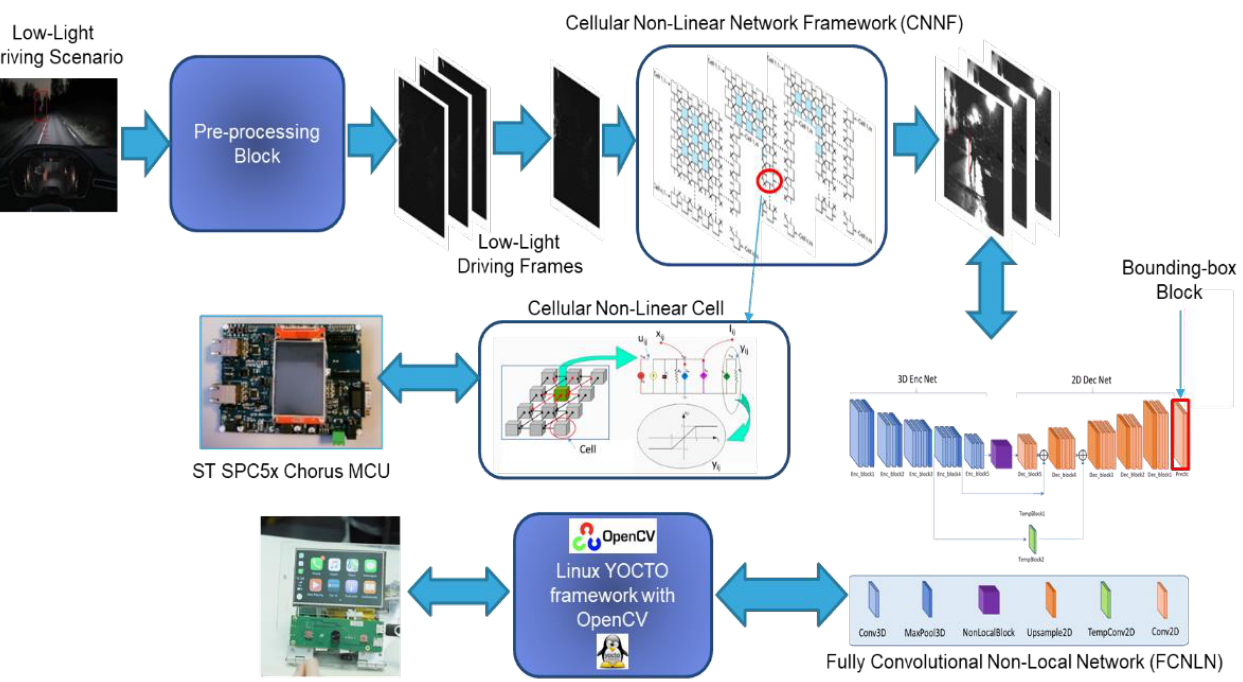
Figure 1. The schematic overview of the proposed pipeline.